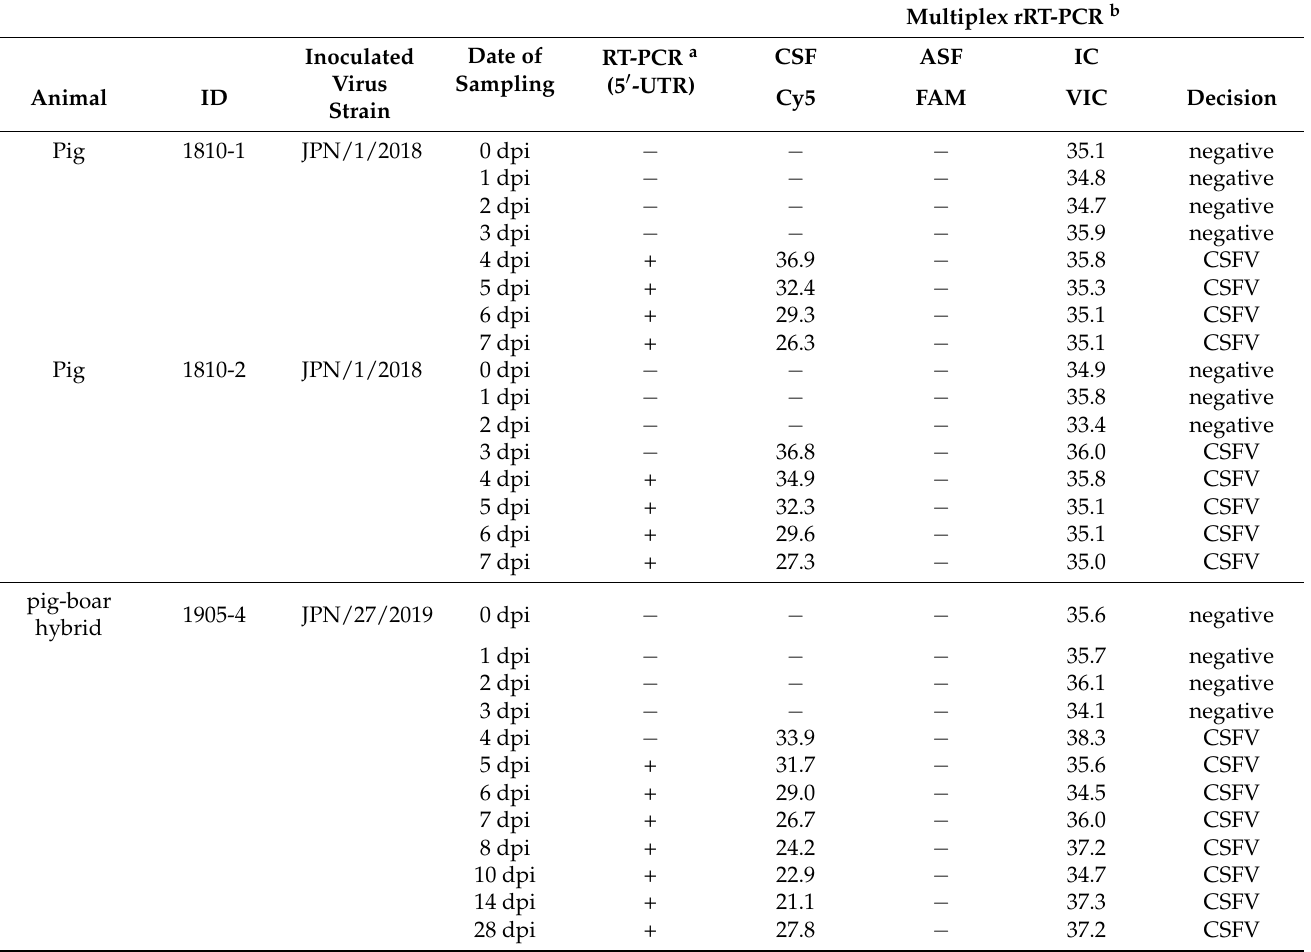
multiplex rRT-PCR detected ASFV-specific fluorescent signals in the test samples of an infected pig (ID 1806-3) one day earlier than the singleplex ASFV rPCR, whereas the same multiplex assay detected positive signals in the samples of another infected pig (ID 1806-7) one day later than the singleplex assay (Figure 5). The Ct value for ASF in the serum of pig ID 1806-7 at 2 dpi (which was ASF negative in the multiplex rRT-PCR) in the singleplex ASFV rPCR was 39.0 indicating that only a few copies of viral genes were present. For the five experimentally infected wild boars (IDs 2002-1 to 5), both assays started to detect ASFV-positive signals on the same day of infection (Table 1). The present results indicated that the newly established multiplex rRT-PCR was comparable to the authentic test method for ASFV diagnosis when serum specimens were used as a test sample. Table 2. Detection of CSFV in sera obtained from pigs and pig-boar hybrids experimentally infected with CSFV Japanese isolates.